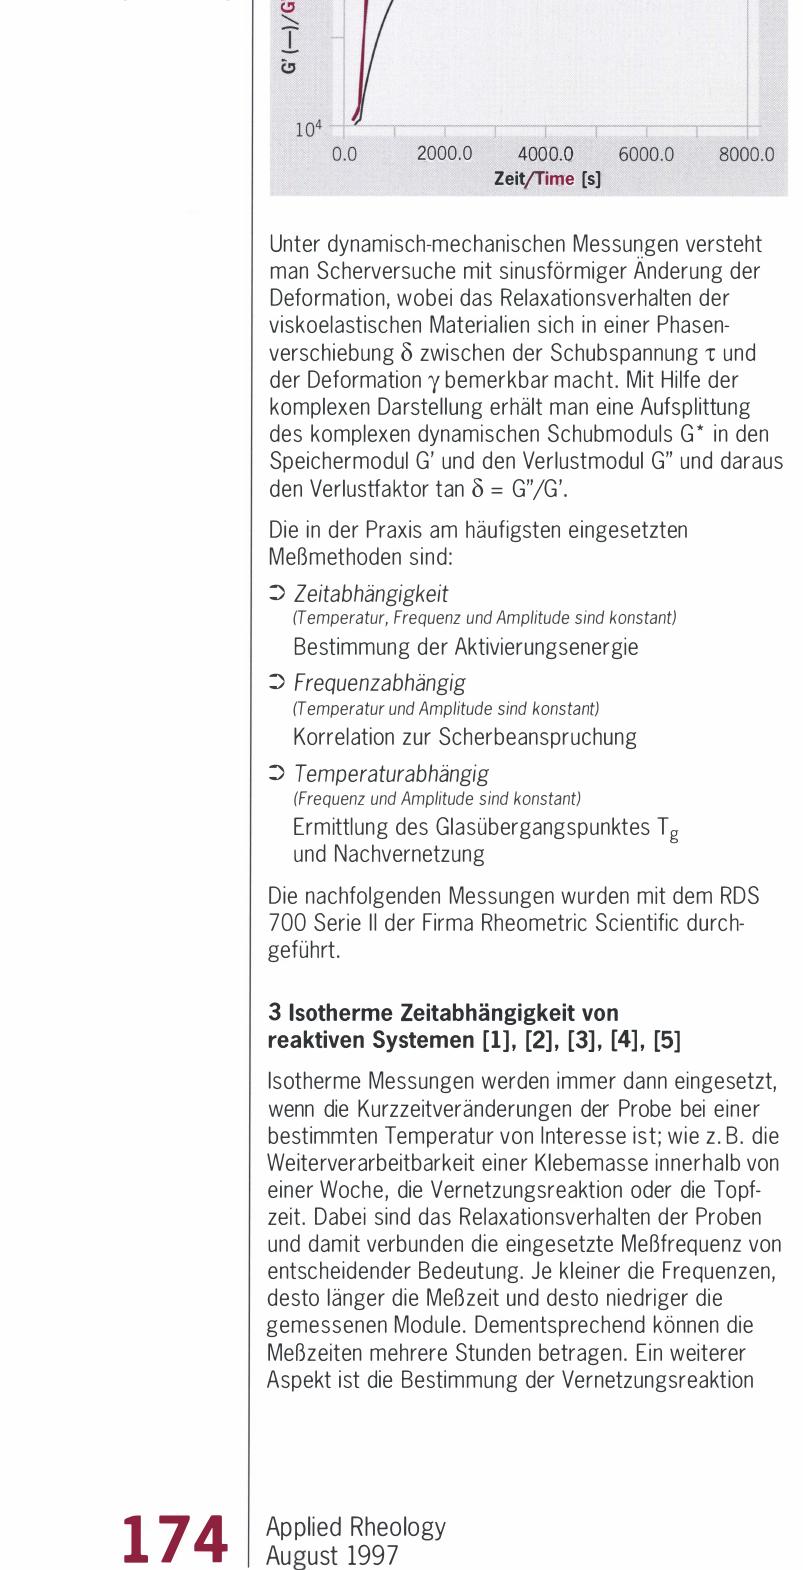
Fig. I: Curves of shear modulus G' measured isothermally during